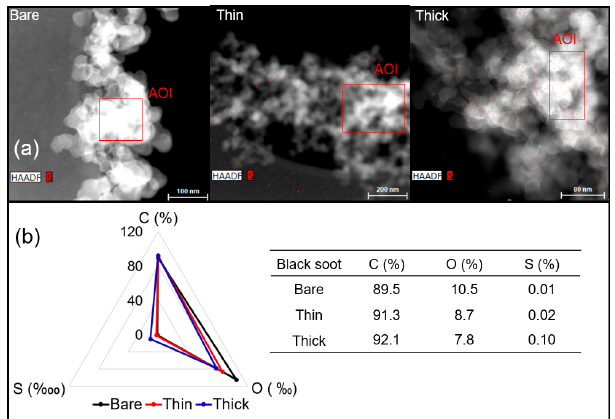
Figure 10. Panel (a) : 2D EDX maps for sulfur (S) on 200nm mCASTblack bare, thinly coated (coating wt = 2.9%) and thickly coated (coating wt = 30.2%) aggregates. Sulfur signal (red dots) is overlain on HAADF (high-angle annular dark-field) images. Scale bars are indicated in each image. Panel (b) : the normalized carbon (C), oxygen (O) and S mass percentage of the areas of interest (AOI, indicated as the red square in panel a ) for mCASTblack soot with different coating thicknesses.